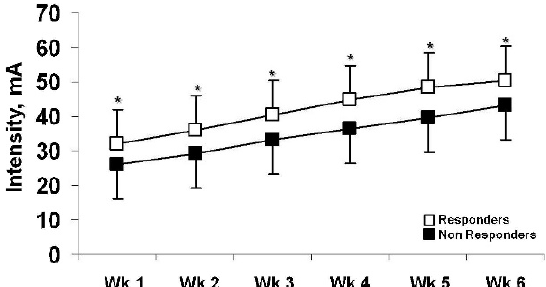
Figure 1 - Intensity of stimulation during hf-NMES training. Note that ‘‘responders’’ (open squares) were training at higher levels of intensity over six weeks than ‘‘nonresponders’’ (solid squares) (* p , 0.05).